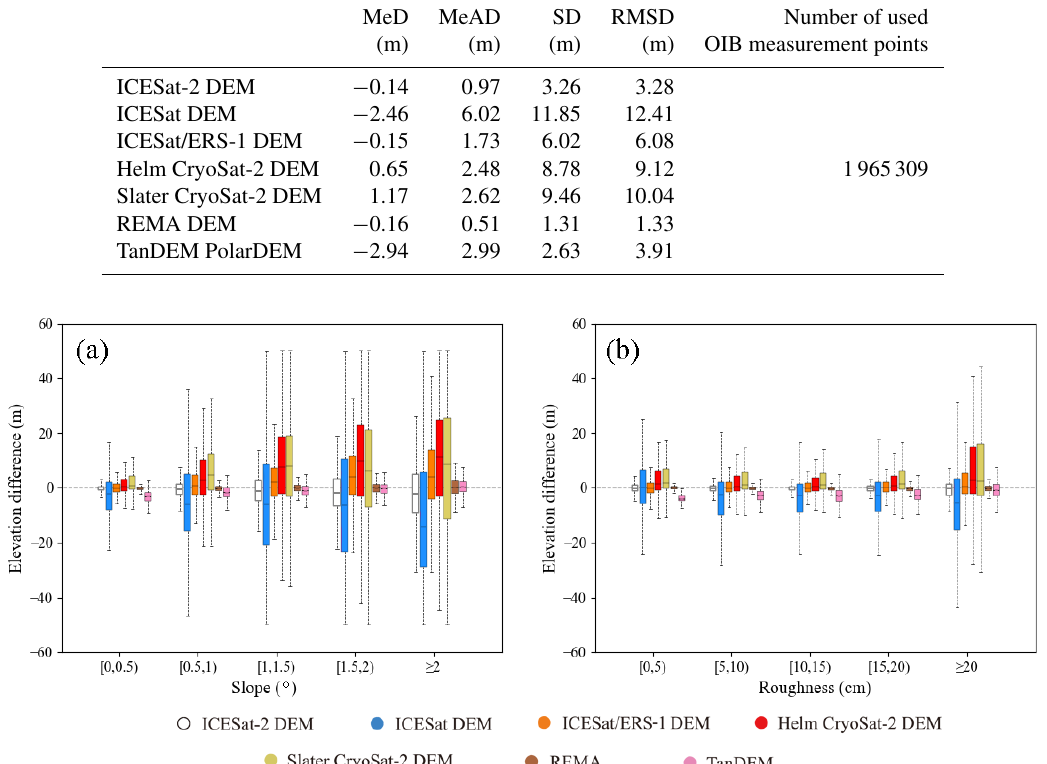
Figure 12. Median differences between seven DEMs and OIB airborne elevation measurements in areas of low elevation change from 2009 to 2019 with respect to surface slope (a) and roughness (b) . The upper and lower lines in each box indicate the 25th and 75th percentiles, the whiskers indicate the 5th and 95th percentiles, and the central horizontal line indicates the median